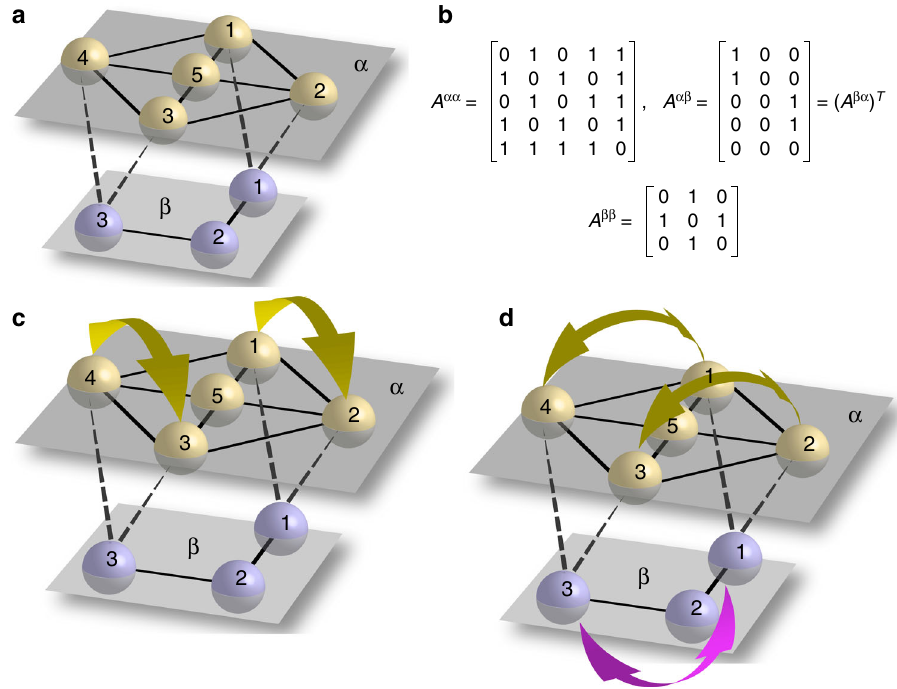
T (in b ). c Example of an independent layer symmetry for the